Question: Identify the chart type used in this figure.
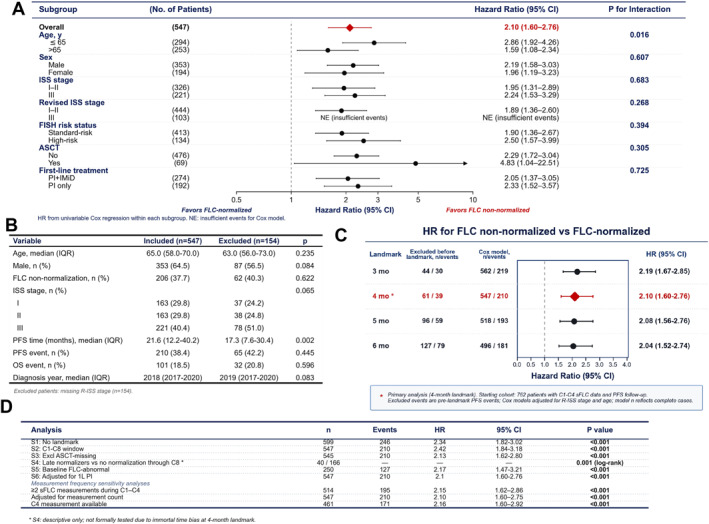
Answer: forest